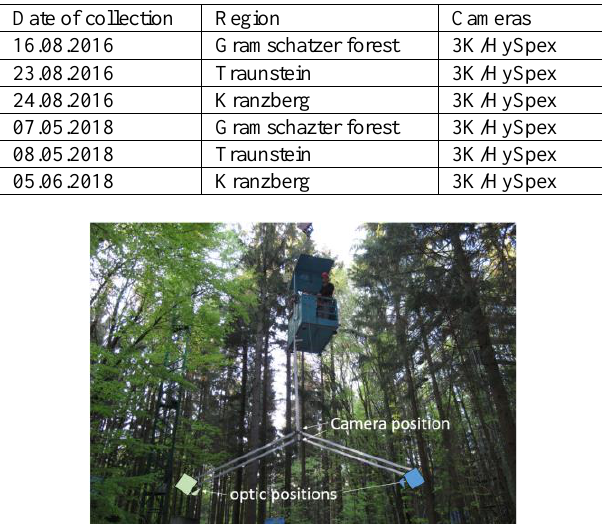
Table1. Airborne data collected for ForDroughtDet project.